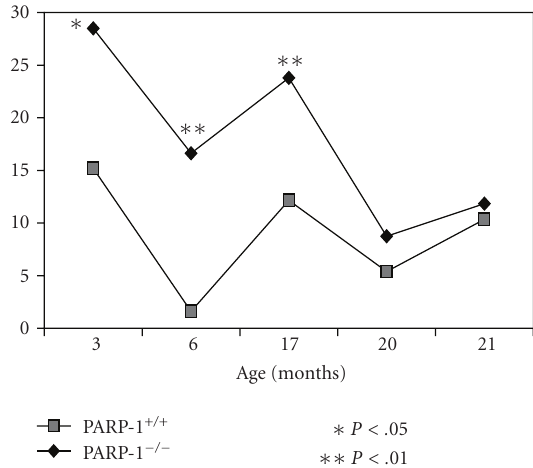
Figure 4: Age-related locomotor activity (“open field” test) in PARP-1 − / − and PARP-1 + / + mice. PARP-1 − / − and PARP-1 + / + mice were tested for their behavior by “open field” at the indicated age. The vertical axis represents the number of vertical sets at indicated age. Student’s t test was performed to analyze the statistical significance of the results.